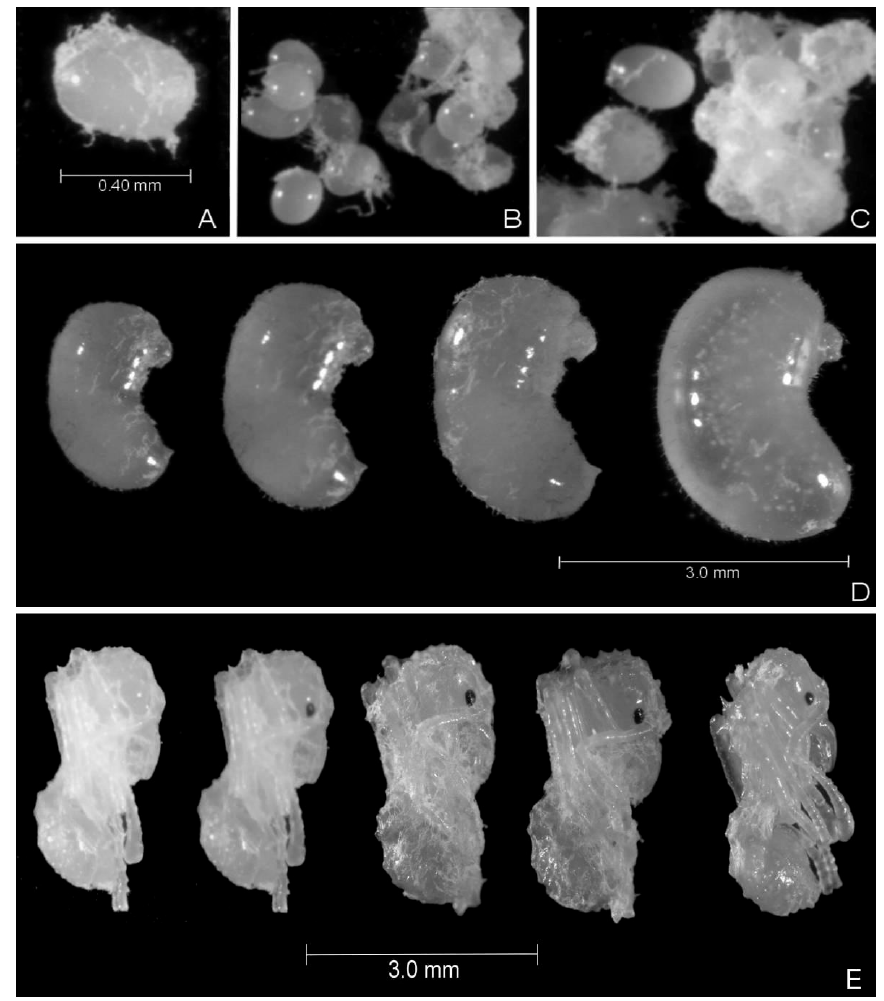
Figure 2. Acromyrmex rugosus rugosus offspring covered by mycelia of the symbiotic fungus. ( A ) Egg shape; ( B ) and ( C ) Grouped eggs; ( D ) Developing larvae, distention in the body and increase in the capacity of the integument indicate the end of the stage; ( E ) Pupae from the beginning of development (white) until near the adult period (dark).